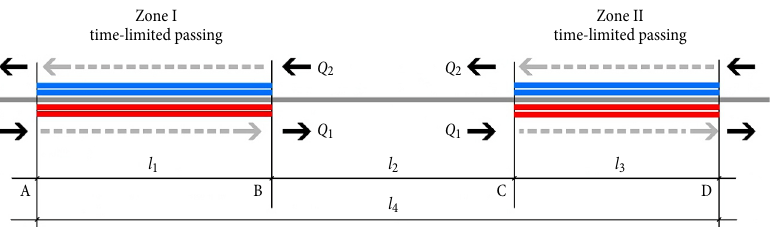
Fig. 1. Traffic problem schema for stopping traffic